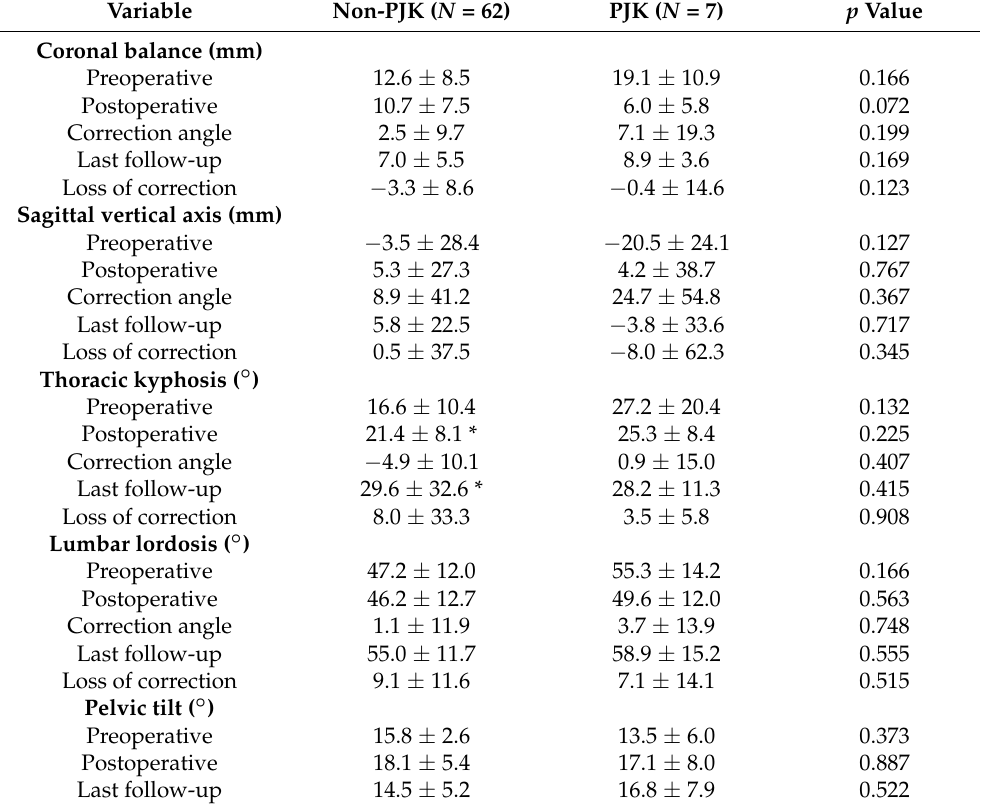
Table 4. Comparison of the balance and sagittal parameters between the non-PJK and PJK